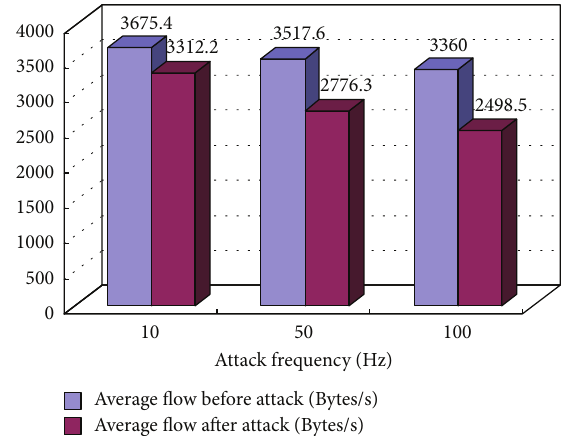
Figure 8: The average flow with different attack frequencies with 3 normal nodes and 1 attack node.